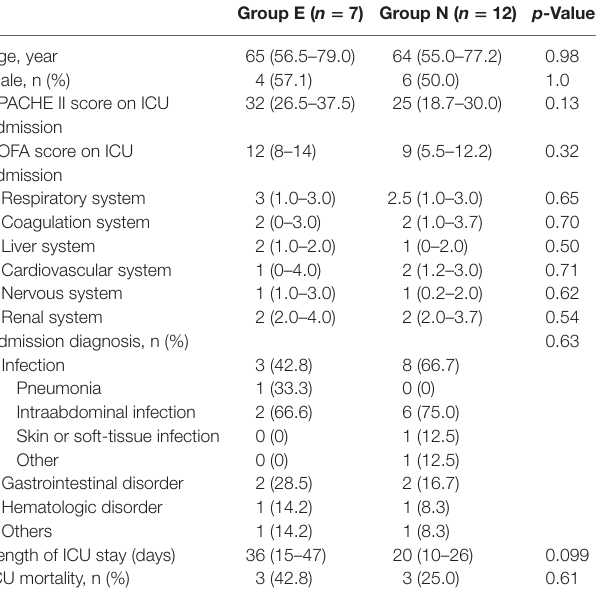
Data are expressed as median (interquartile range), or number (%), as appropriate. APACHE II, Acute Physiology and Chronic Health Evaluation II; SOFA,